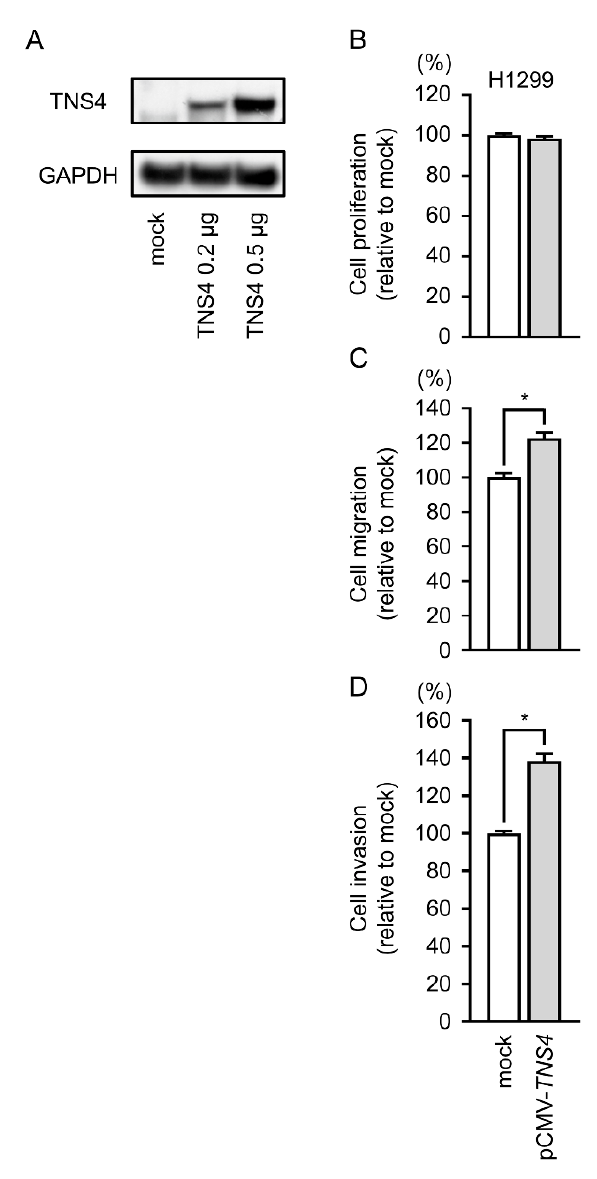
Figure 7. The effects of TNS4 overexpression by H1299 cells. ( A ) Expression levels of TNS4 protein 48 h after transfection with pCMV- TNS4 vector into H1299 cells. ( B ) Cell proliferation was evaluated by XTT assays. ( C ) Cell migration was determined by wound healing assay 24 h after forward transfection with the pCMV- TNS4 vector. ( D ) Cell invasion was determined by Matrigel assay 24 h after forward transfection with the pCMV- TNS4 vector. These assays showed that migratory and invasive activities were increased in pCMV- TNS4 vector-transfected cell lines. * p < 0.01.